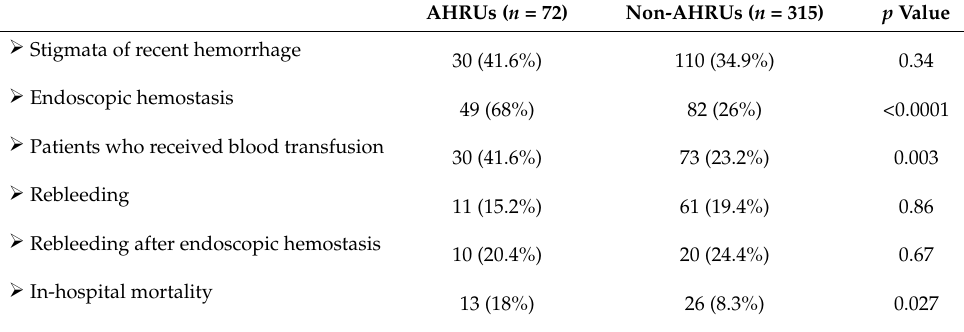
Table 3. Treatment outcomes of AHRU in comparison to non-AHRU lower gastrointestinal bleeding. AHRUs ( n = 72)